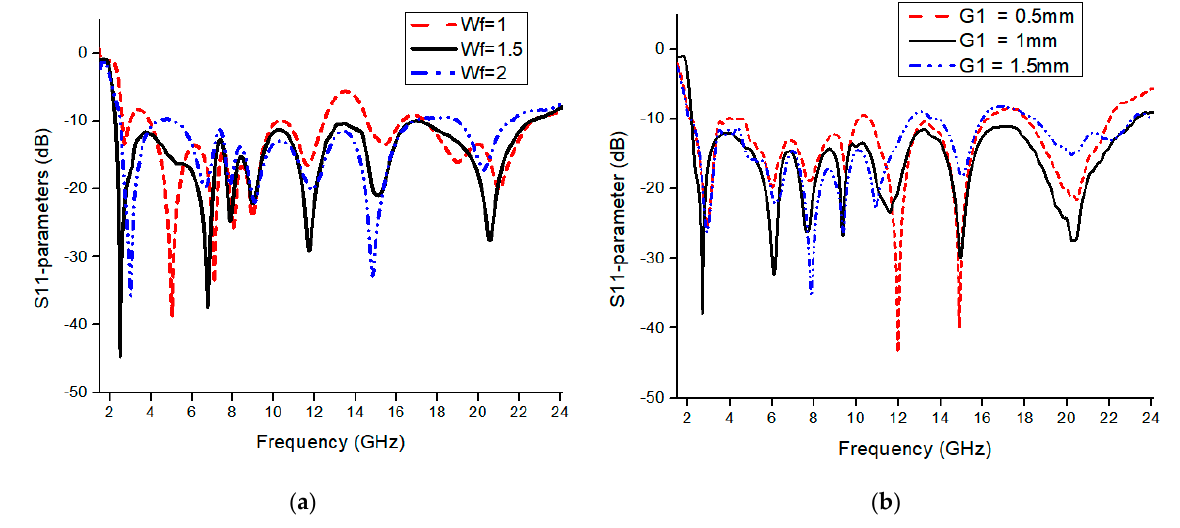
Figure 4. Simulation response of ( a ) feedline and ( b ) square ring.